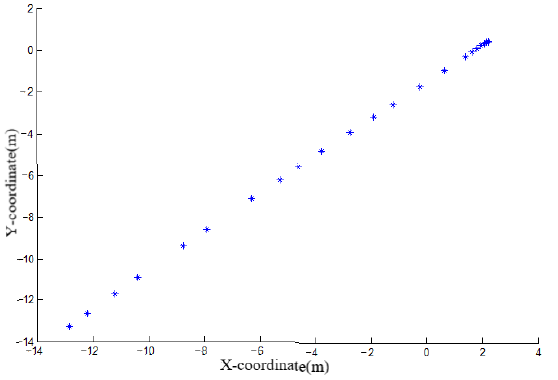
Figure 12. X-Y coordinates of SMC.